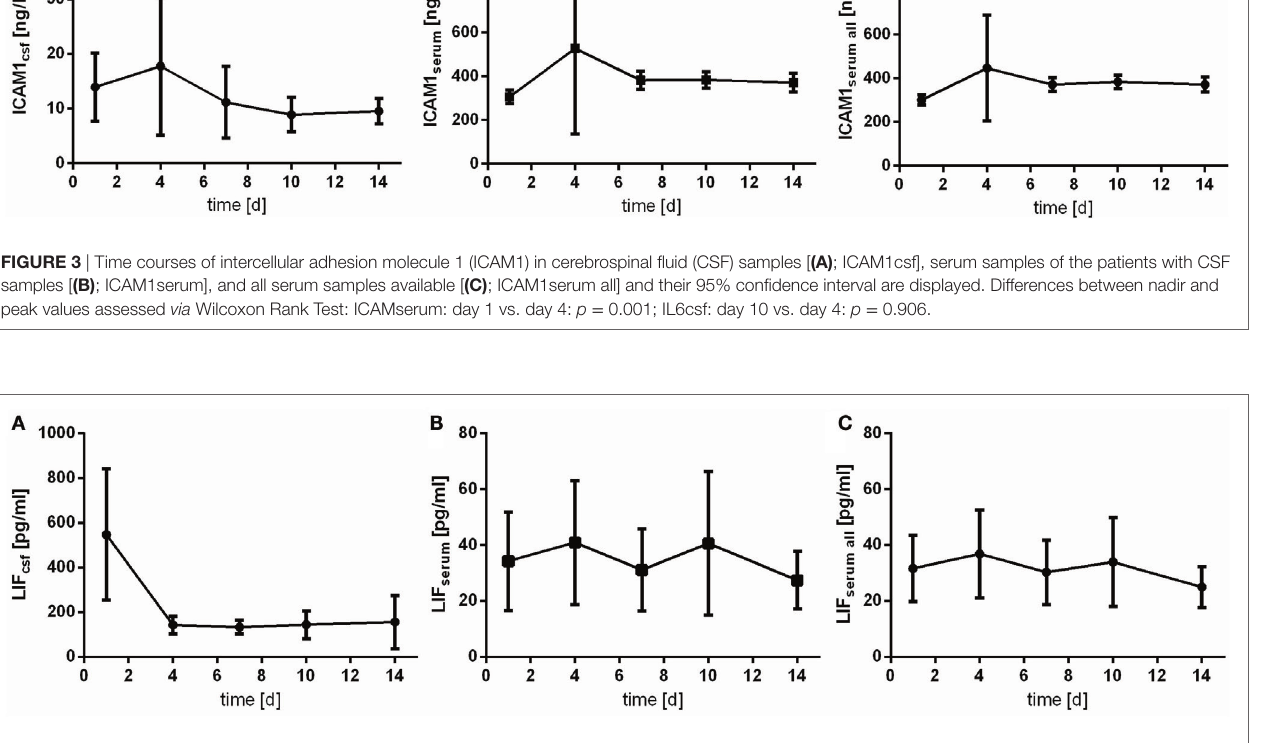
FigUre 4 | Time courses of leukemia inhibitory factor (LIF) in cerebrospinal fluid (CSF) samples [ (a) ; LIFcsf], serum samples of the patients with CSF samples [ (B) ; LIFserum], and all serum samples available [ (c) ; LIFserum all] and their 95% confidence interval are displayed. Differences between nadir and peak values assessed via Wilcoxon Rank Test: LIFserum: day 14 vs. day 4: p = 0.081; IL6csf: day 4 vs. day 1: p < 0.0001.